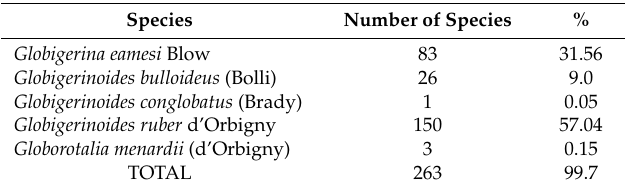
Table 2. Planktonic foraminifera species diversity and dominance from the same 50-gr. sample (see Table